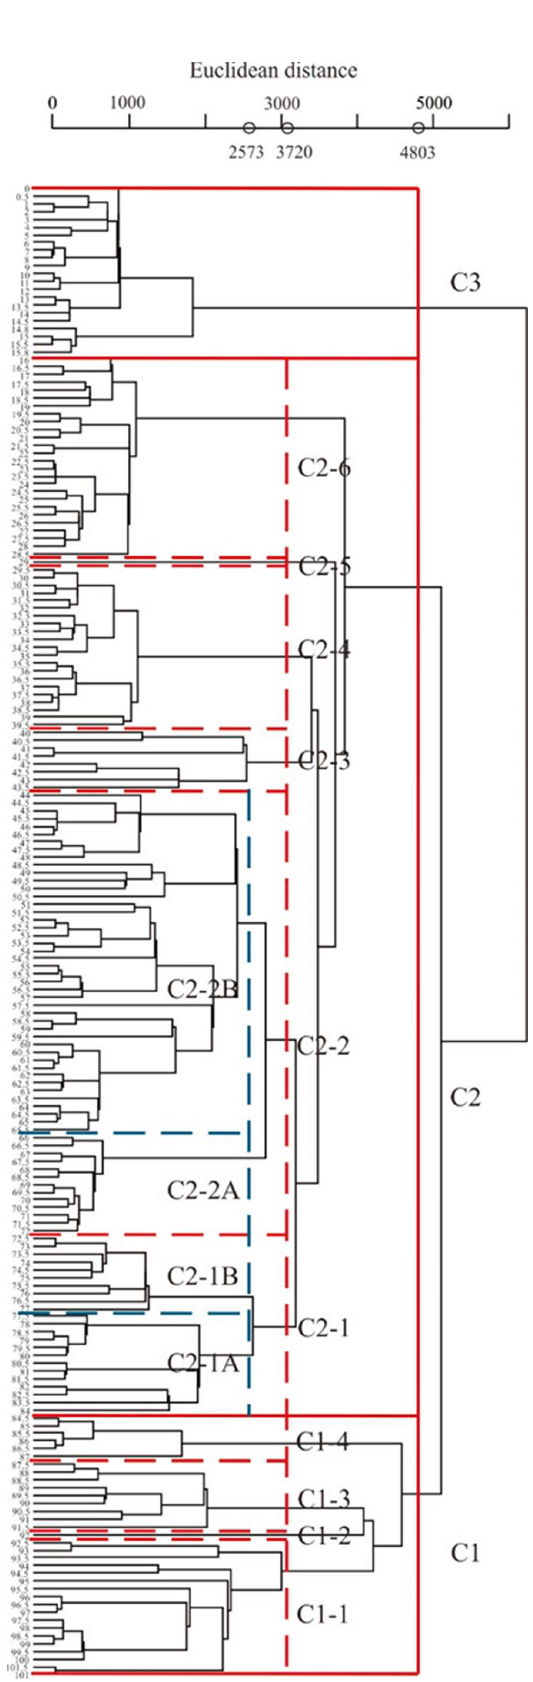
Figure 2. The dendrogram derived from the constrained clustering analysis.